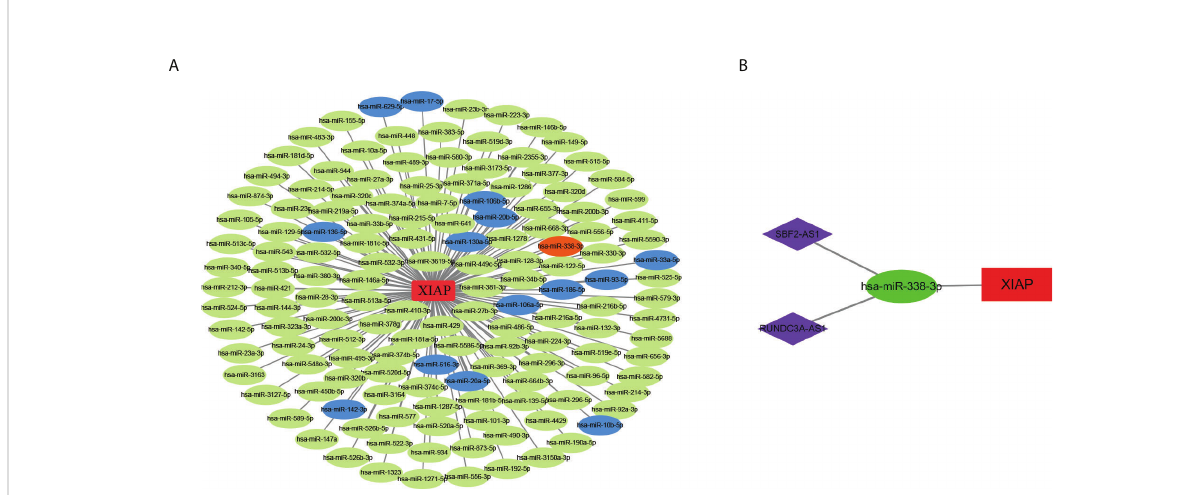
FIGURE 5 The construction of lncRNAs-miRNAs-XIAP network. (A) The miRNAs and XIAP network in LUAD. Green nodes indicated signi fi cant differential miRNAs associated with XIAP in TCGA database. Blue nodes suggested the miRNAs positively correlated with XIAP in Starbase (The Correlation coef fi cient ≥ 2, and P-value < 0.001), while orange node indicate negatively. (B) the ceRNA network of SBF2-AS1, RUNDC3A-AS1, hsa-miR-338- 3p, and